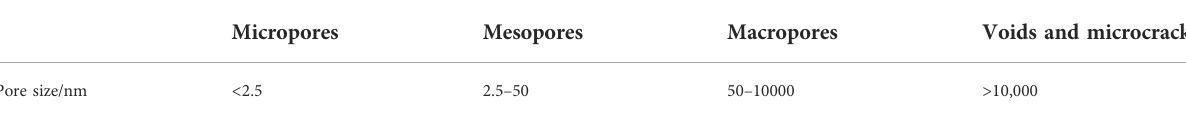
TABLE 5 Classi fi cations of pores in the AAS pastes.